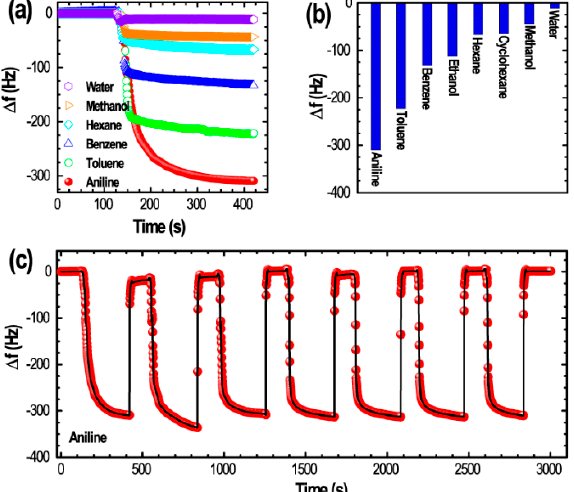
Figure 5. Vapor sensing performance of bitter melon shape nanoporous C 60 crystals: ( a ) Frequency shifts ( ∆ f ) upon exposure of QCM electrode to water, methanol, hexane, benzene, toluene and aniline as typical example; ( b ) Summary of sensor performance, and ( c ) Repeatability test upon exposure and removal of toluene vapors up to seven cycles.